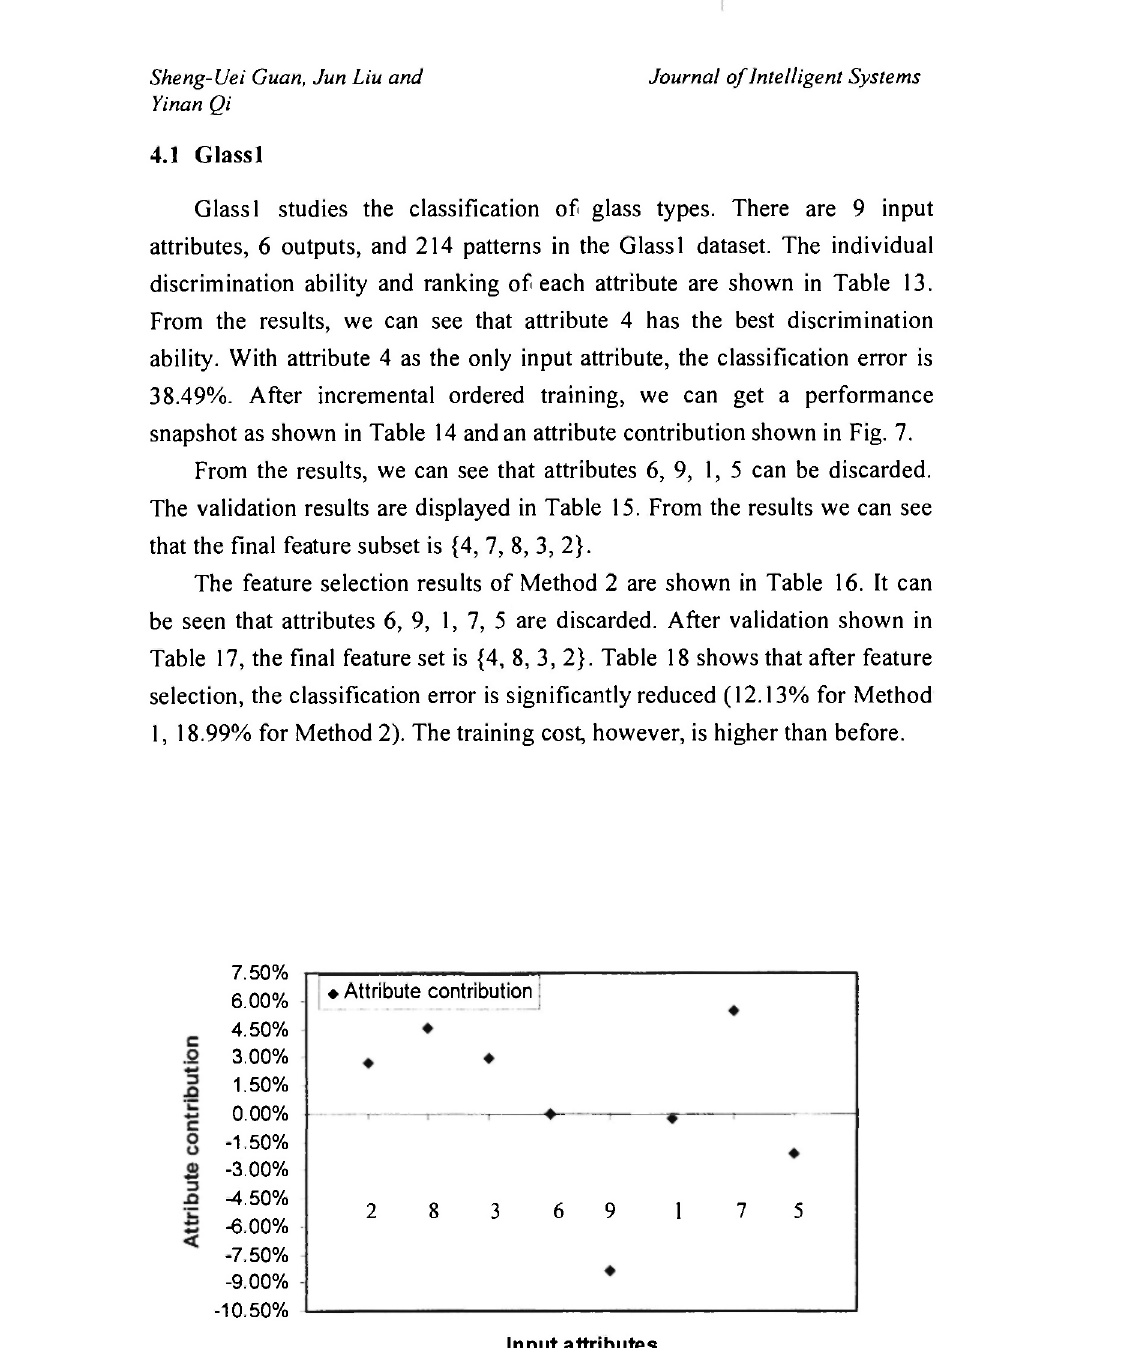
Fig. 7: Attribute contribution - Glass